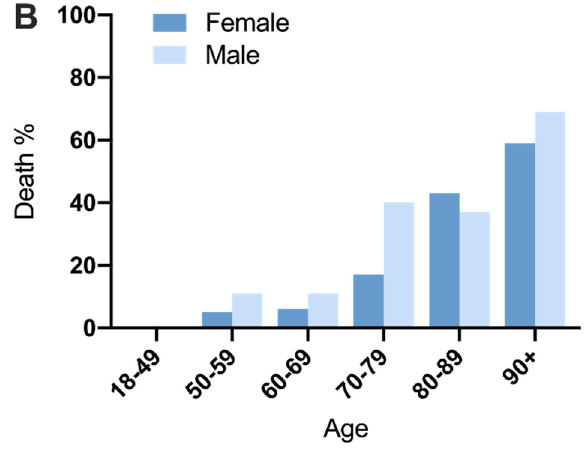
Figure 3. ( A ): Admissions by age and sex of cohort of 316 patients. ( B ): Percentage of deaths 315 patients with a confirmed clinical outcome, stratified by age and among 315 patients with a confirmed clinical outcome, stratified by age and sex.